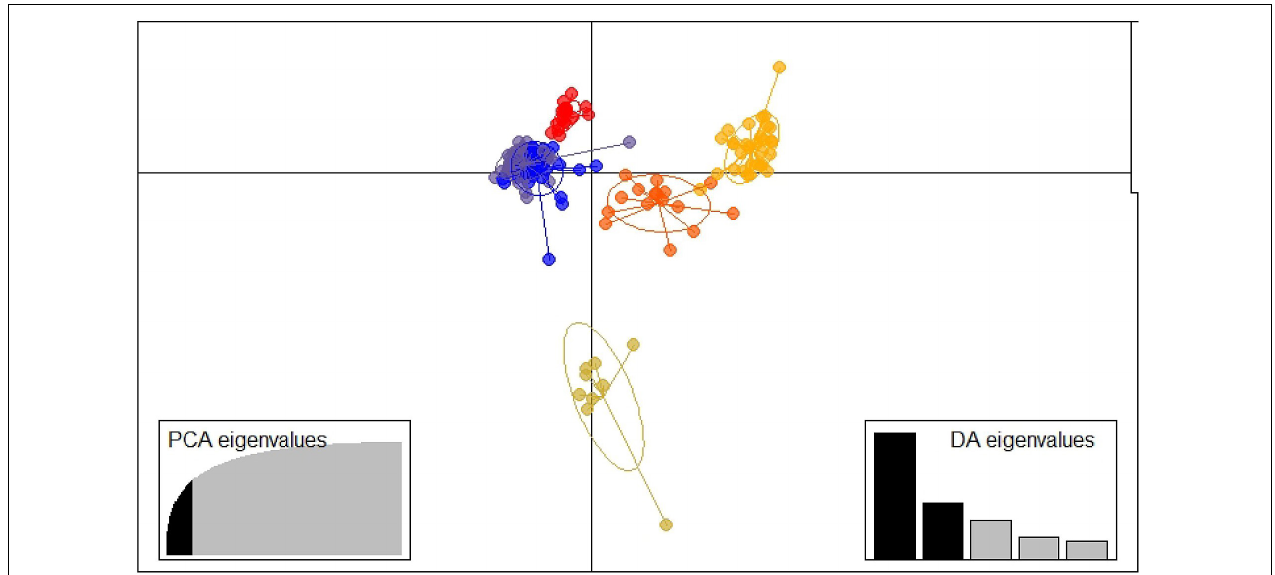
FIGURE 3 | Discriminant analysis of principal components structure plot k = 6. ID is described in Supplementary Table 1